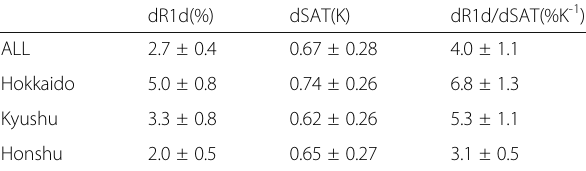
Table 4 Differences in R1d (dR1d) and SAT (dSAT) between d1.5 and d2 with standard errors of the ensemble